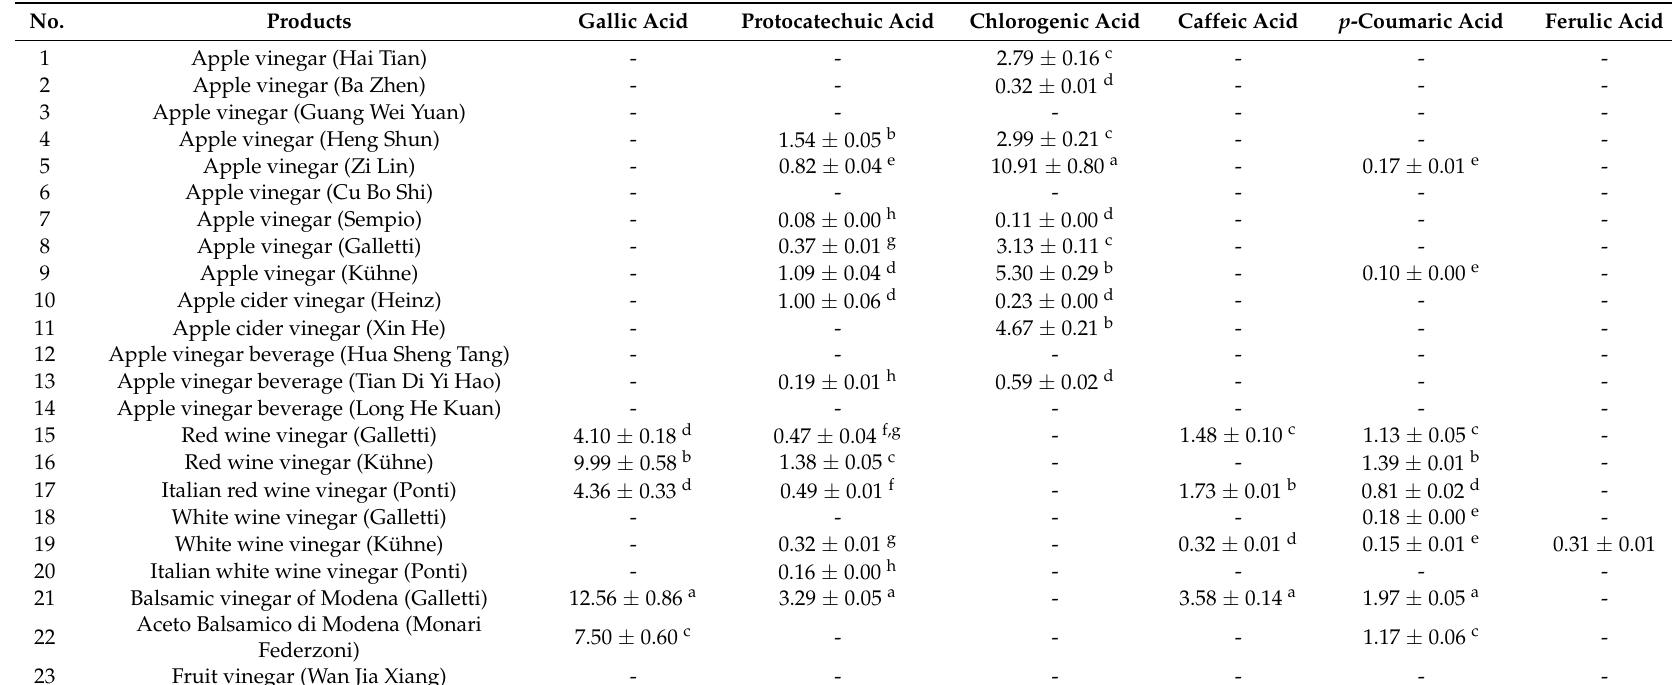
Table 3. Main phenolic compounds and their contents in 23 fruit